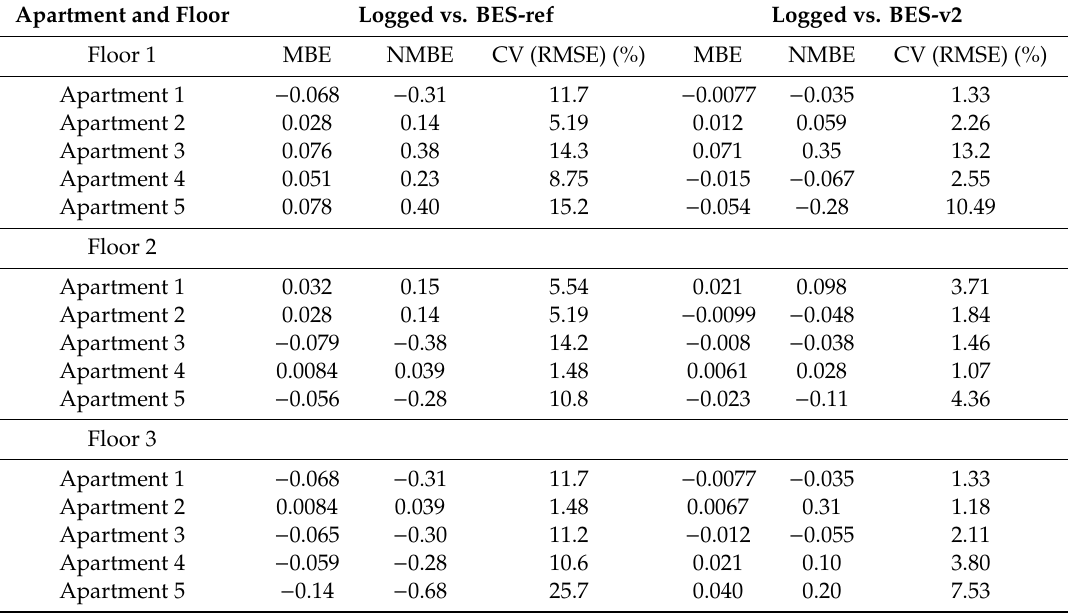
Table 13. Mean bias error (MBE), normalized mean bias error (NMBE), and coe ffi cient of variation (CV) of the root-mean-square error (RMSE) for logged measurements of temperature and the simulated results for BES-ref and